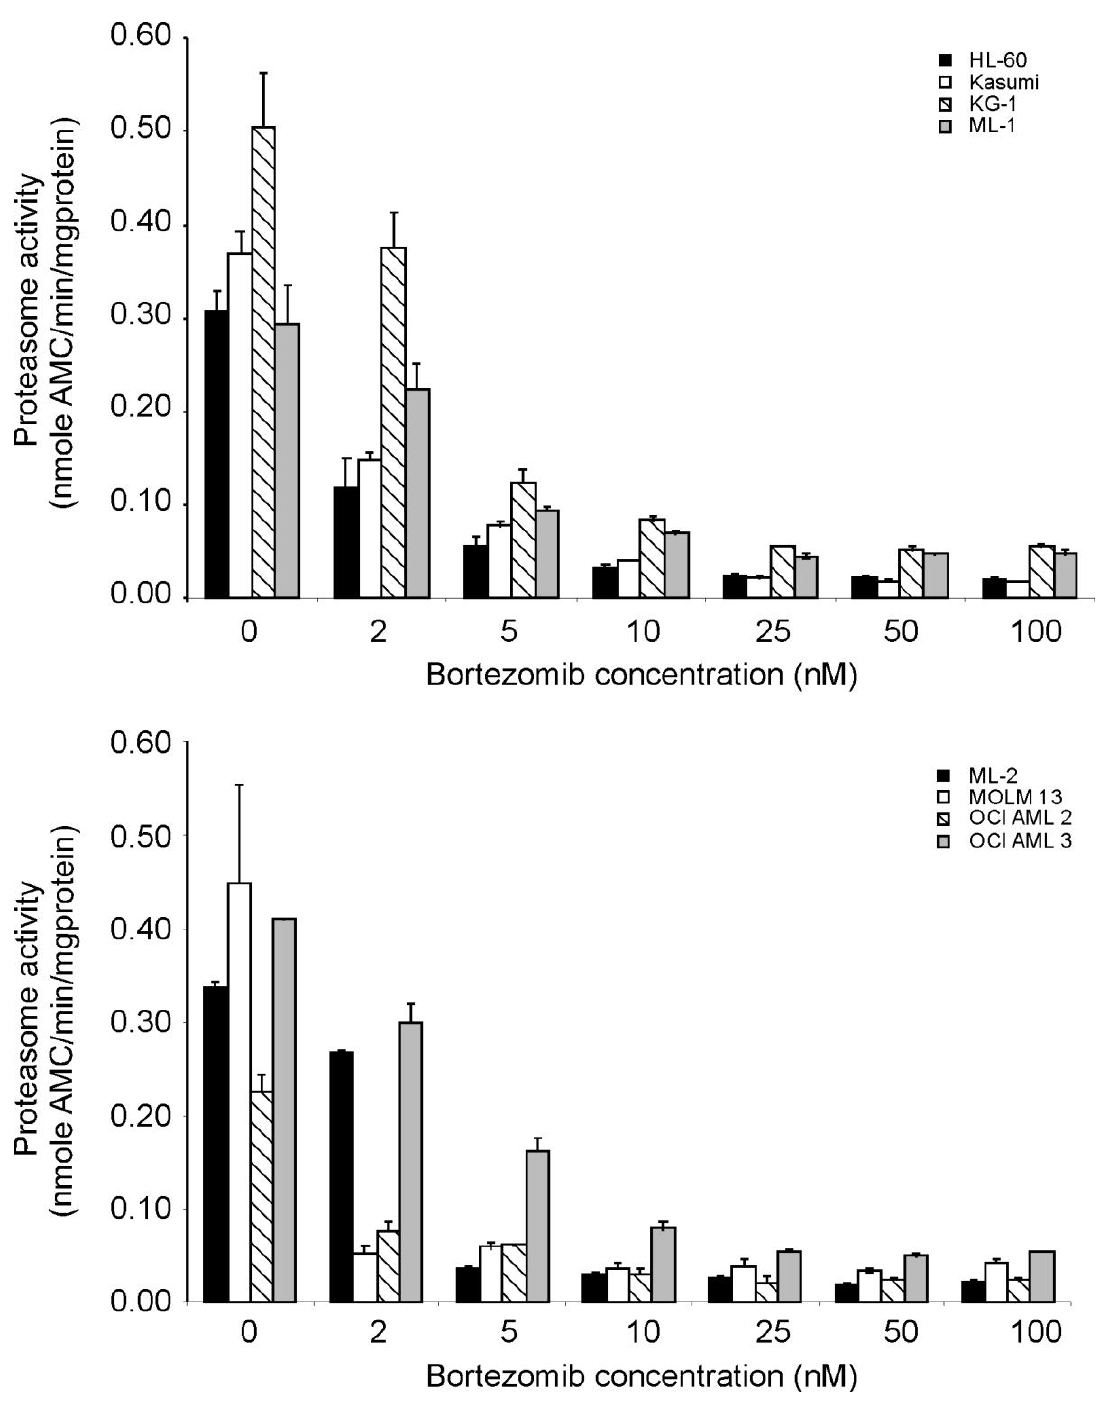
Figure 4. Proteasome inhibition increases with increasing concentration of bortezomib. AML cells were treated with increasing doses of bortezomib (0–100 nM) for 6 h. Proteasome activity is expressed as nmoles substrate (AMC) cleaved per 1 mg cellular protein in one minute ±